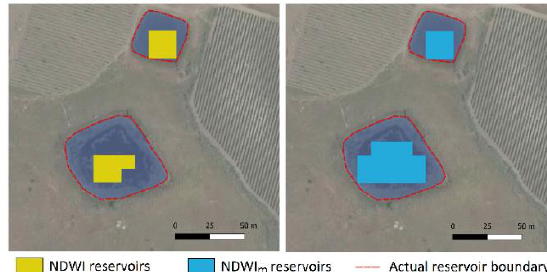
Figure 11. Details of the reservoir maps in Figure 10. For the reservoir at the bottom of the images, the NDWI m is more effective in detecting the water cells along the boundary of the water body.